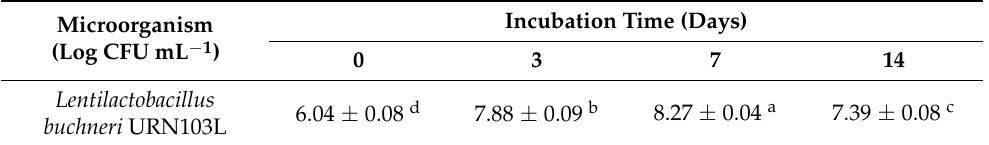
Table 1. Viable cell count of Lentilactobacillus buchneri URN103L after 14 days of fermentation in 20% ginseng root suspension.